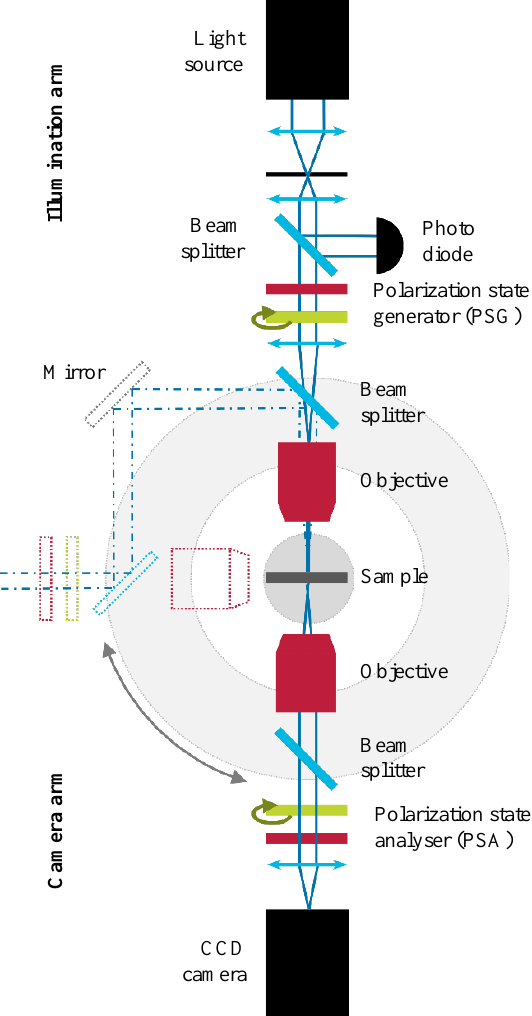
Fig. 1. Schematic representation of the Mueller matrix microscope